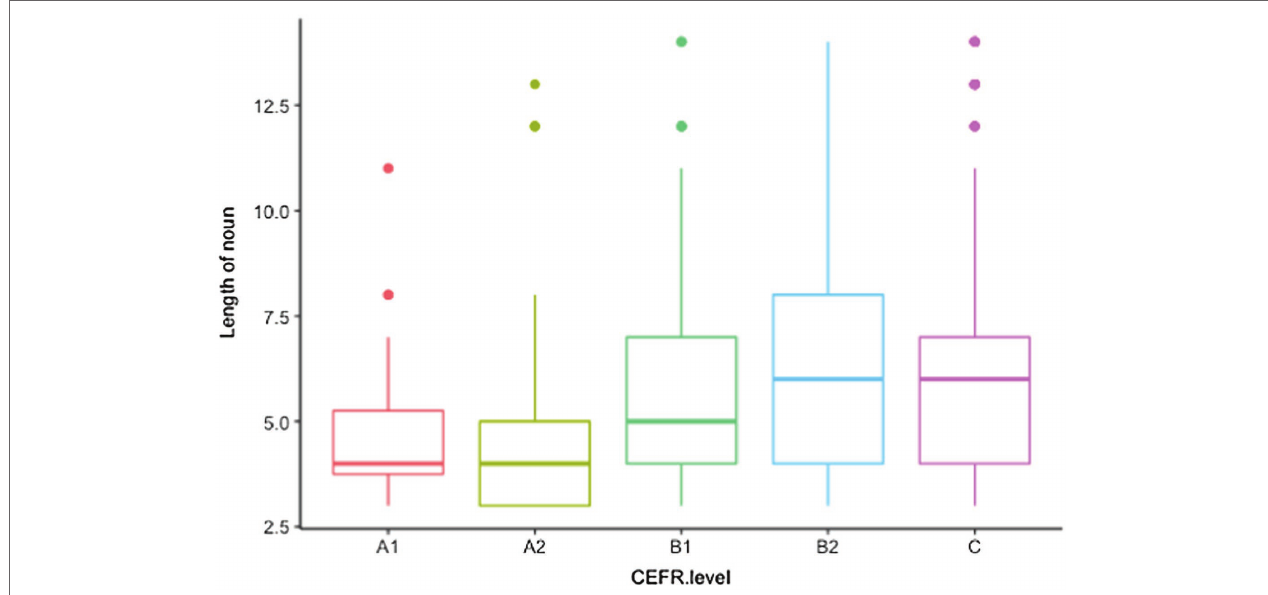
Adjusted residuals appear in parentheses below observed frequencies.